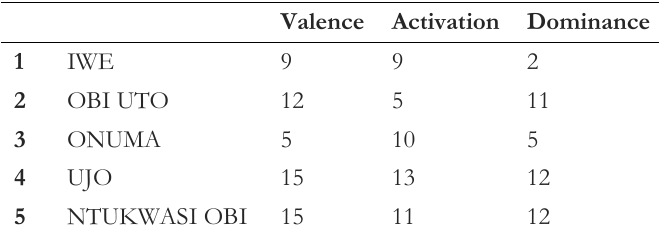
Table 7. Sample result of tolerance-limit processing.